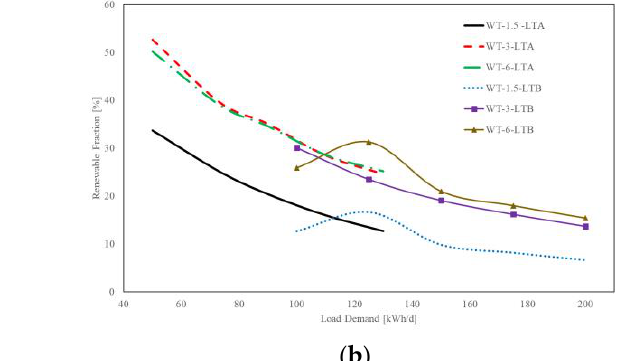
Figure 11. Load demand parametric study for the default wind pattern for different wind turbines. ( a ) COE vs. load demand; ( b ) Ren.Fr. vs. load demand.